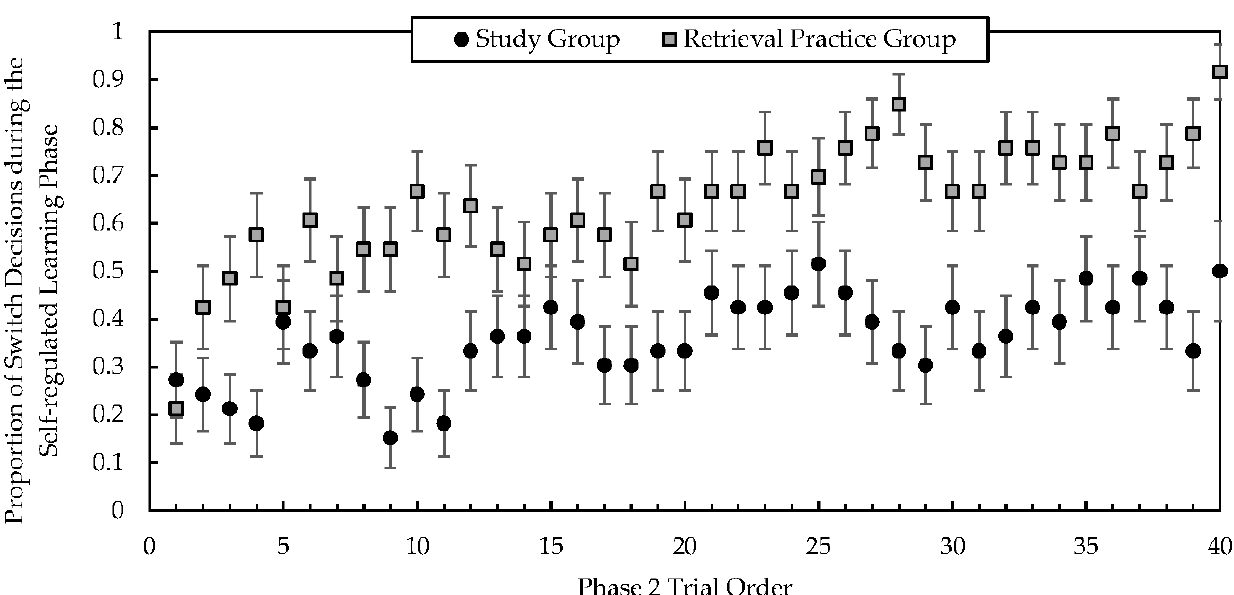
Figure 3. Values represent the mean proportion of switch decisions for each trial order position of the Phase 2 self-regulated learning phase separately for each group. Even though students could select to complete more than 40 trials, all students were required to complete 40 trials before proceeding to the test phase; thus, the graph presents study order decisions from trial 1 to trial 40. Error bars represent the standard error of the mean.